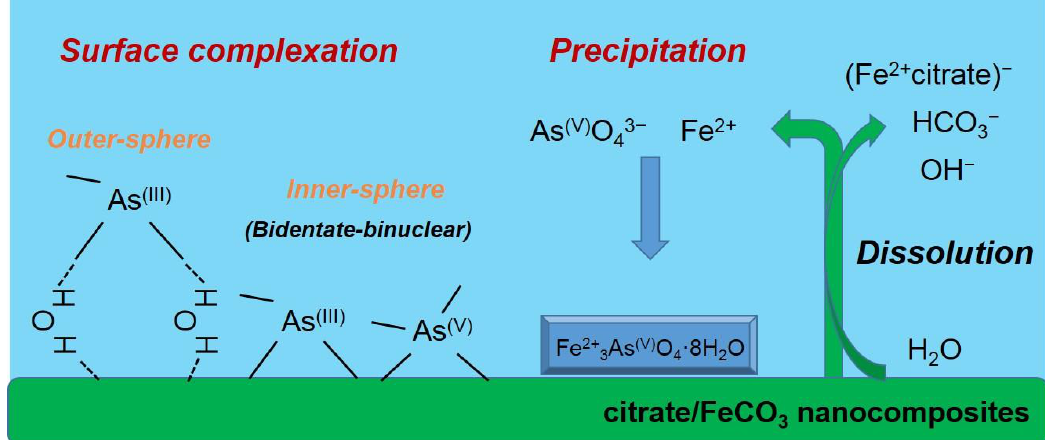
Figure 11. Schematic illustration of suggested mechanism(s) of arsenic (III and V) uptake by CF-NCs.